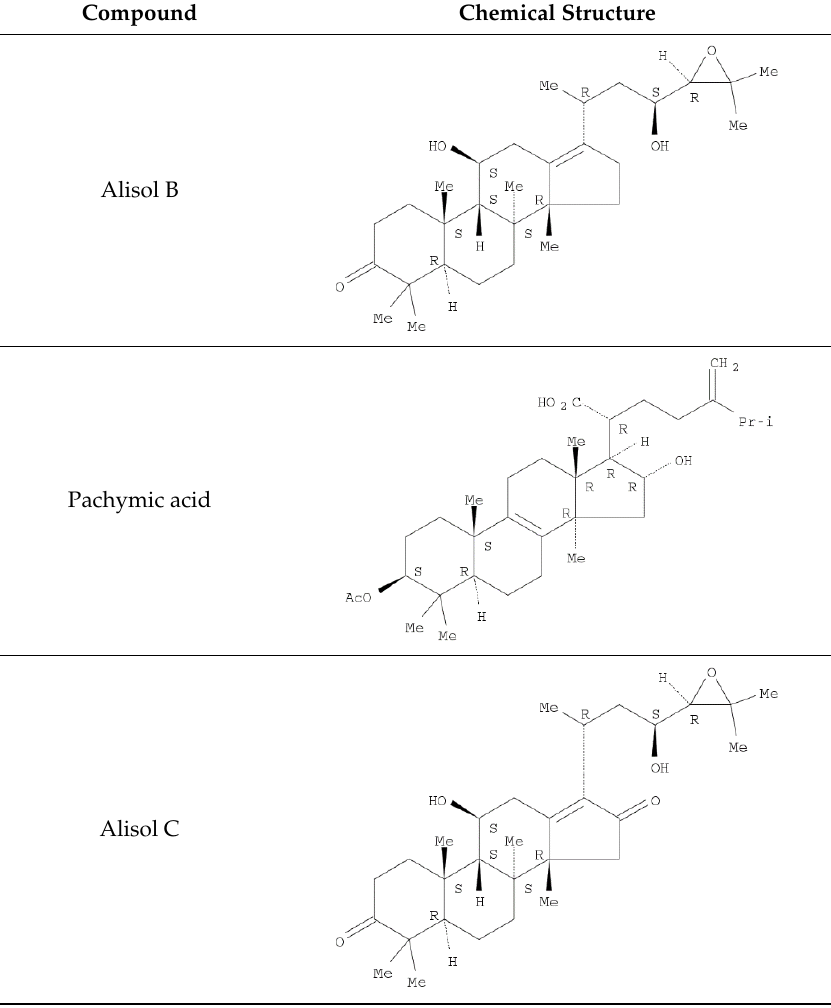
Table 1. The structures of the nine analytes monitored in Qi Ju Di Huang Wan (QJDHW). Compound